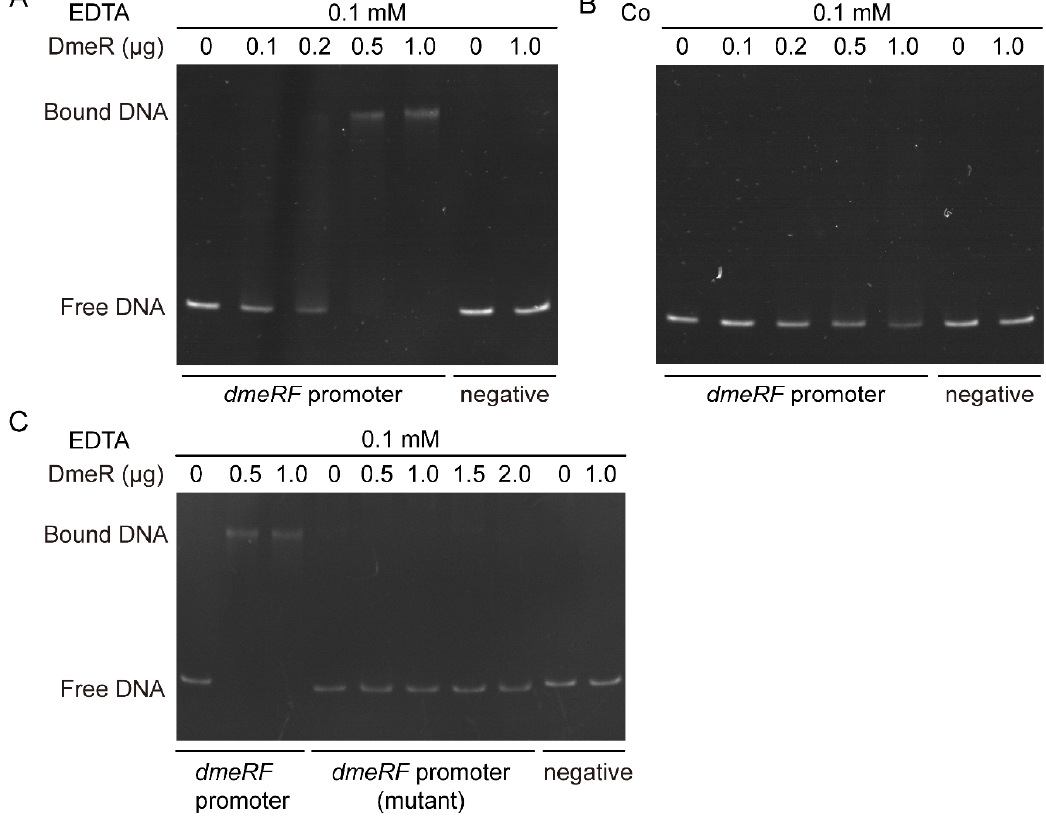
Figure 8. Electrophoretic mobility shift assays. ( A , B ) Purified rDmeR was incubated with